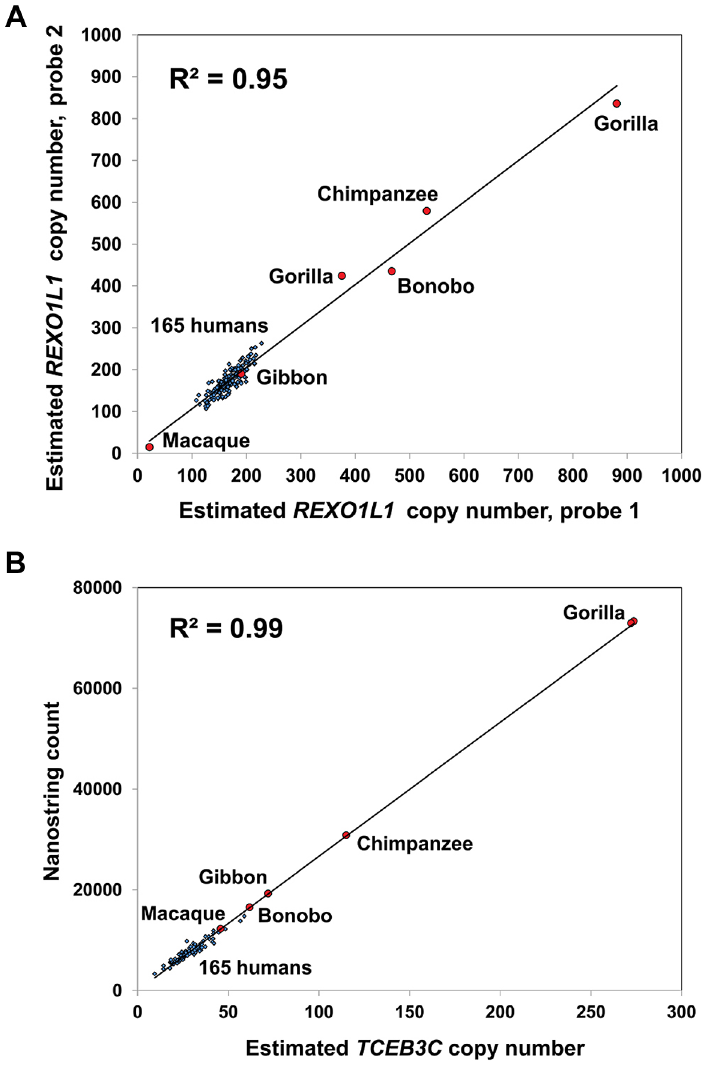
Figure 6. REXO1L1 and TCEB3C show extreme variation in copy number among primate species. ( a ) REXO1L1 is one of the most extreme examples of copy number variable genes in human, with 108–266 copies of the , 12.2 kb repeat unit observed in the 165 HapMap individuals studied. However even more extreme variation is observed among different primates. We observed , 450 and , 550 copies in bonobo and chimpanzee, respectively, and copy numbers of , 400 and , 860 in two different gorilla individuals. In contrast while macaque has an estimated 22 copies, gibbon falls within the same range seen in human. ( b ) While TCEB3C ranges from 9–59 copies among HapMap individuals (mean 29 copies), all five species of primate studied show increased copy number, indicating a reduction of TCEB3C copy number specifically in the human lineage. As with REXO1L1 , gorilla and chimpanzee showed the highest copy numbers, with 115 in chimpanzee and , 270 copies in both gorillas studied.